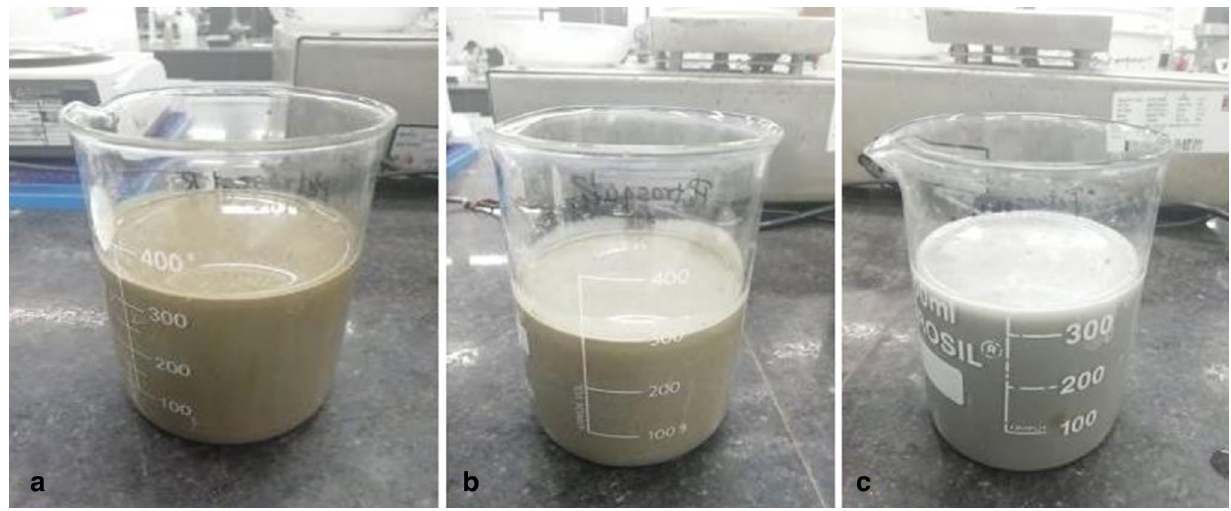
Fig. 5 Samples of the developed drilling formulations using different particle sizes of the proposed additive and PAC a 250-297 µm, b 63–74 µm, c PAC